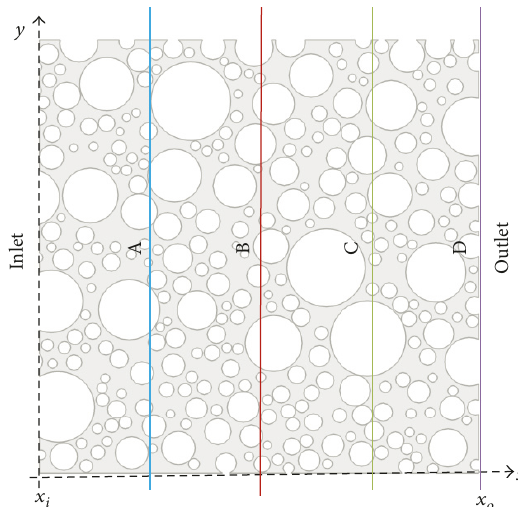
Figure 2: Computational domains adopted for the pore-scale modeling. Reference lines A, B, C, and D divide the computational domain into four equal